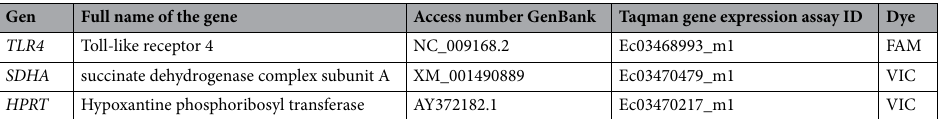
Table 1. Probes used for amplification of TLR genes and housekeeping